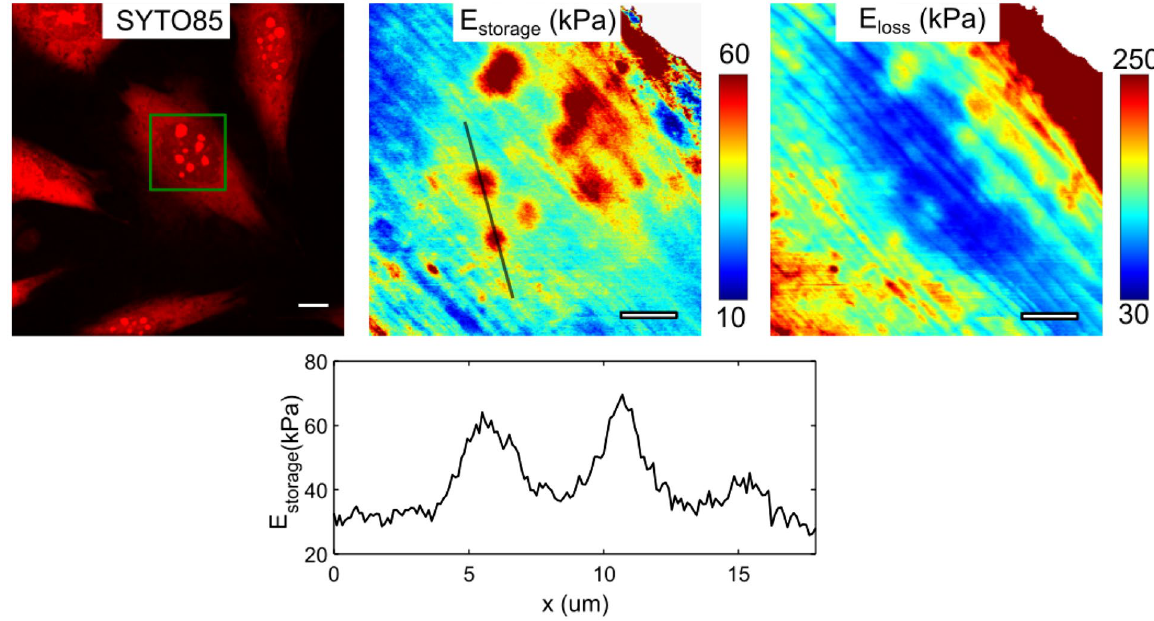
Figure 5. NIH 3T3 fibroblast, nanomechanical maps obtained over the nucleus region. Cross-section of the E storage moduli over the two nucleoli (line on the map). E storage above the nucleoli is about twice higher than above the surrounding area. Scale bars are 10 µm for the SDCM image, 5 µm for the nanomechanical